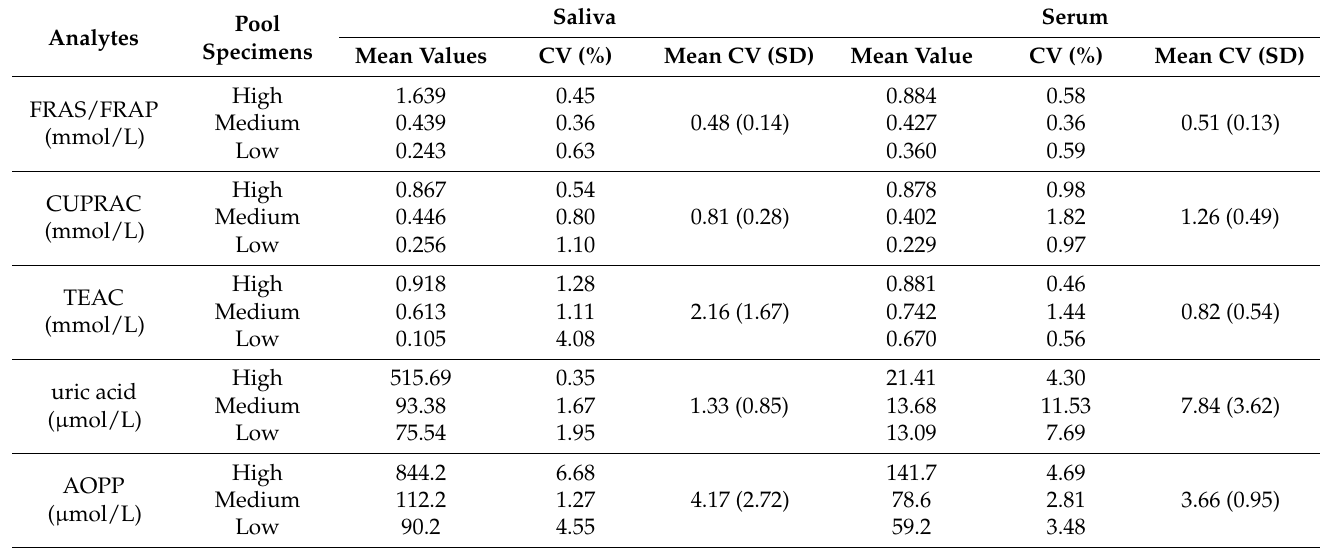
Table 1. Intra-assay coefficients of variation (CVs) in saliva and serum pool specimens with different ferric reducing abilities of saliva/serum (FRAS), cupric reducing antioxidant capacity (CUPRAC), Trolox equivalent antioxidant capacity (TEAC), uric acid, and advanced oxidation protein products (AOPP) levels.